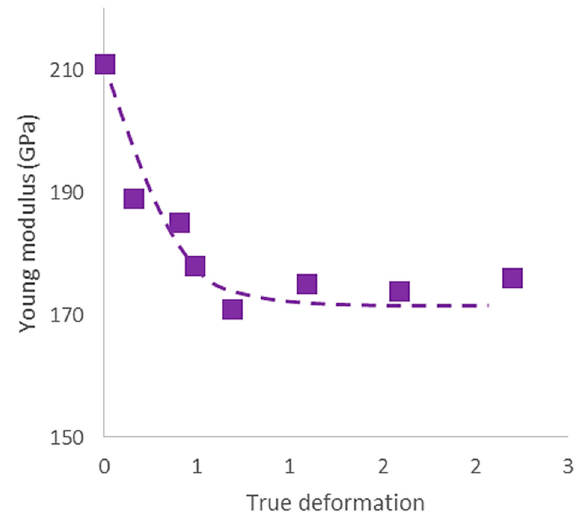
Figure 4. Young’s modulus variation with the thickness reduction during grooved cold rolling (maximal incertitude ± 6 GPa).